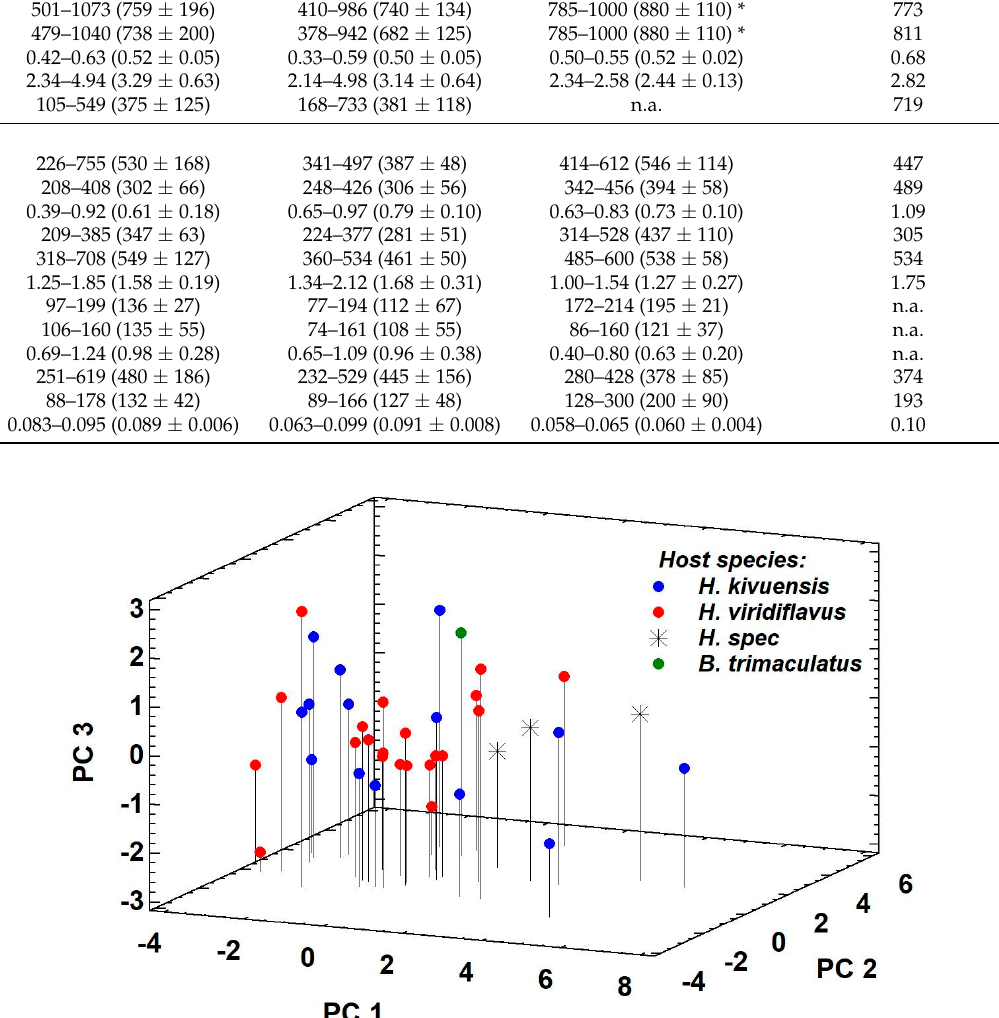
Figure 2. Morphometric features of Clinostomum chabaudi metacercariae collected from four host species. Specimen data are given as principal component scores derived from variables describing body size and sucker morphology (for details see text). Each dot represents a single specimen, the asterisks the type specimens in Vercammen-Grandjean (1960) [11].